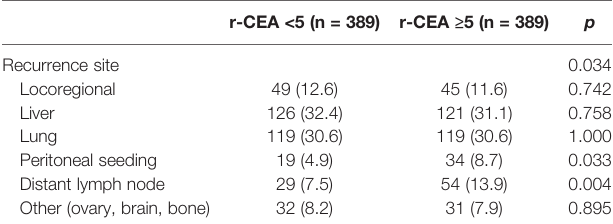
TABLE 4 | Long-term oncologic outcomes of matched